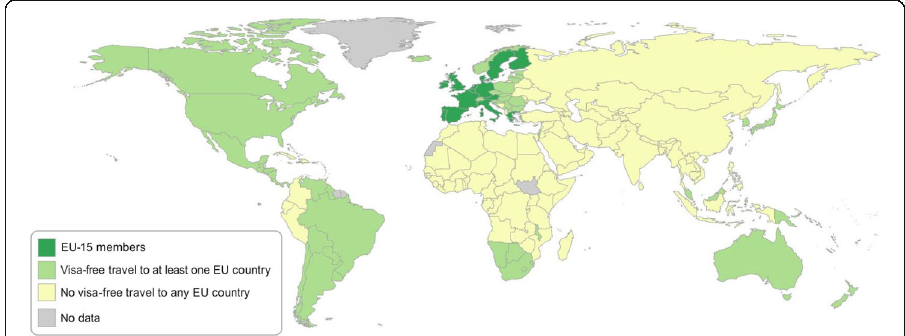
Fig. 2 Mapping the world in terms of territorial access: Visa-free travel to at least one Western European country in 2010. Own Research, Data Source: IATA/Visa Network Data 2010, Illustration created with